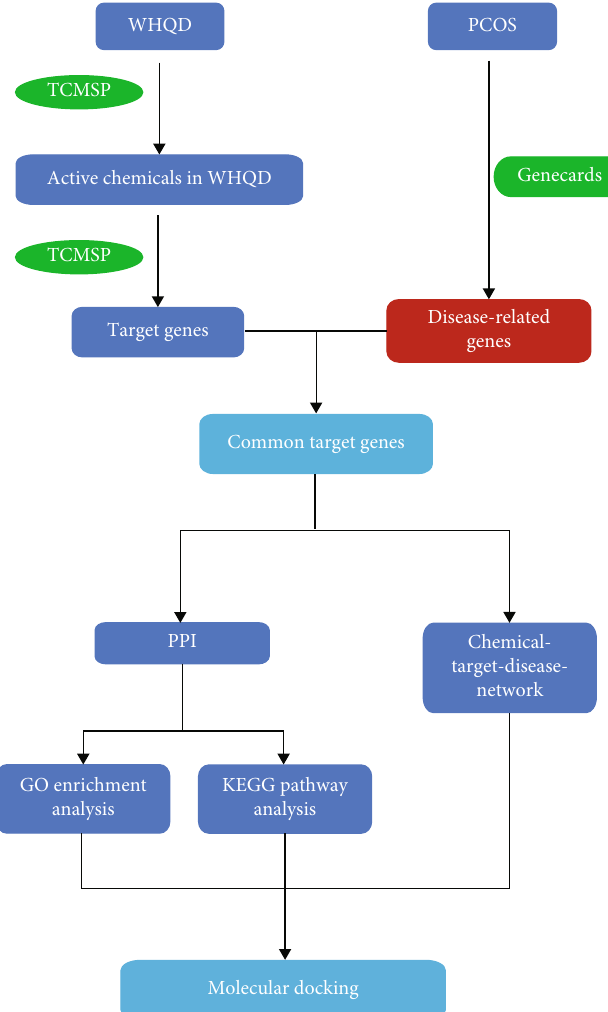
Figure 1: The fl owchart of the whole study